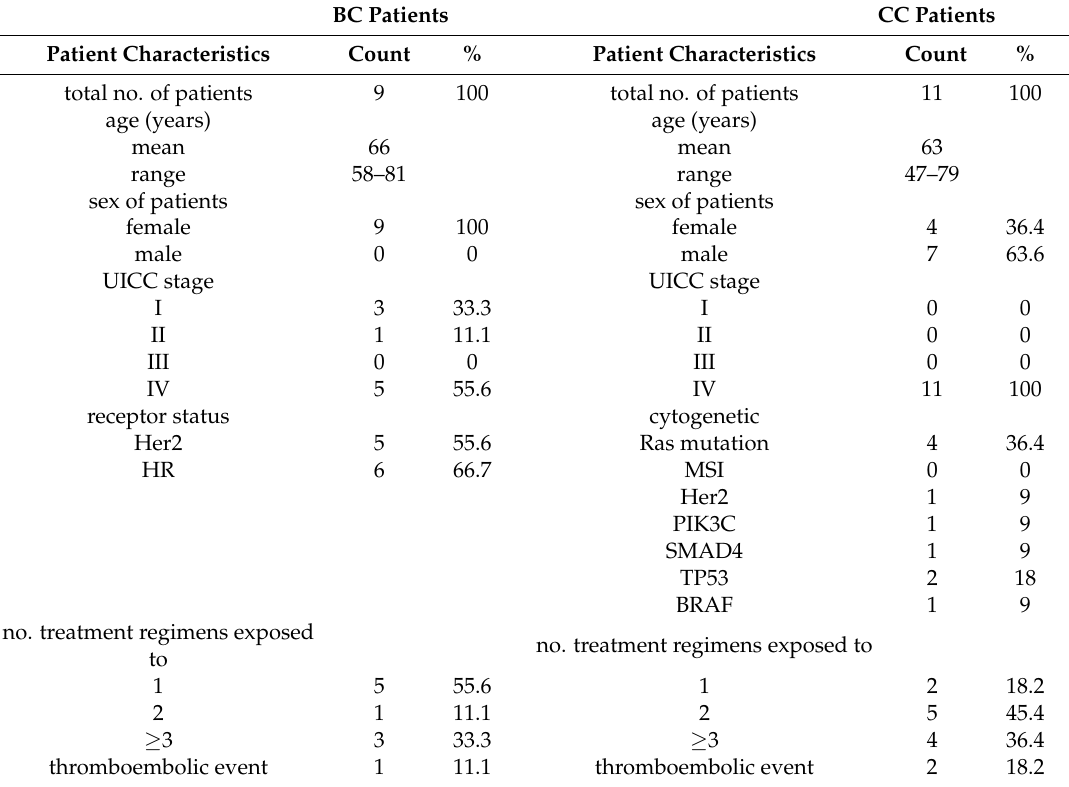
Table 1. Patient